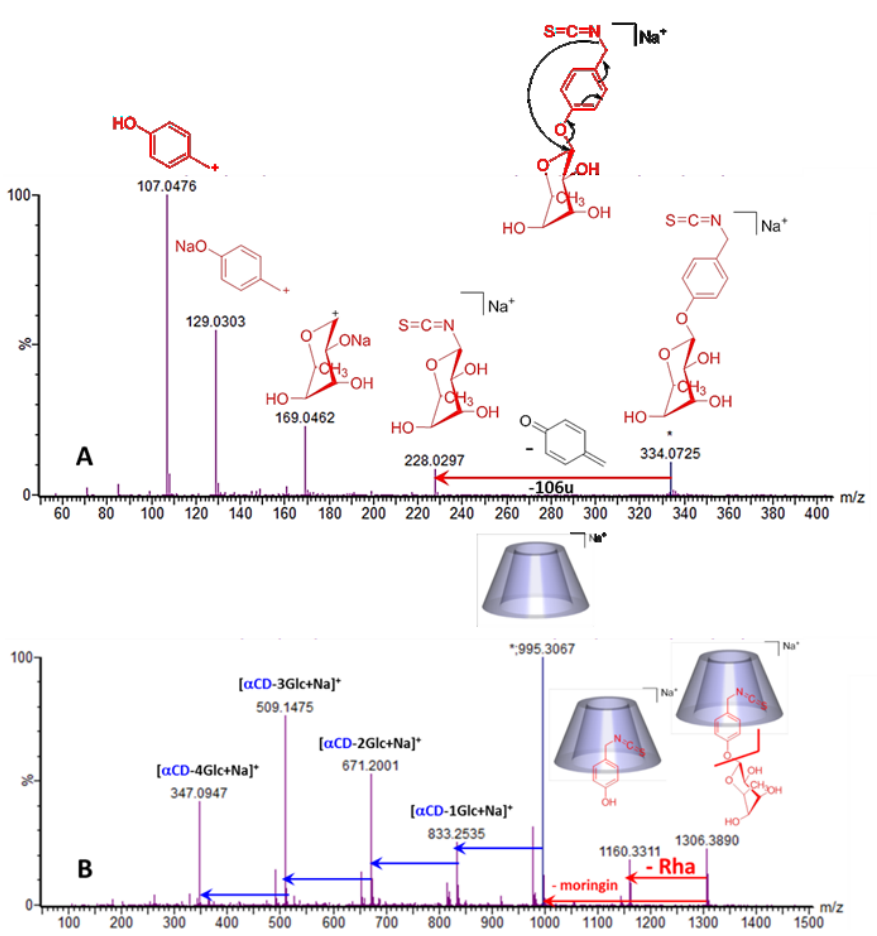
Figure 12. Mass spectrometry (MS/MS) spectra of water solutions of MOR alone (0.5 mM) ( A ) and in presence of α-CD (0.5 mM) ( B ) recorded respectively at a collision energy of 25 eV and 95 eV.